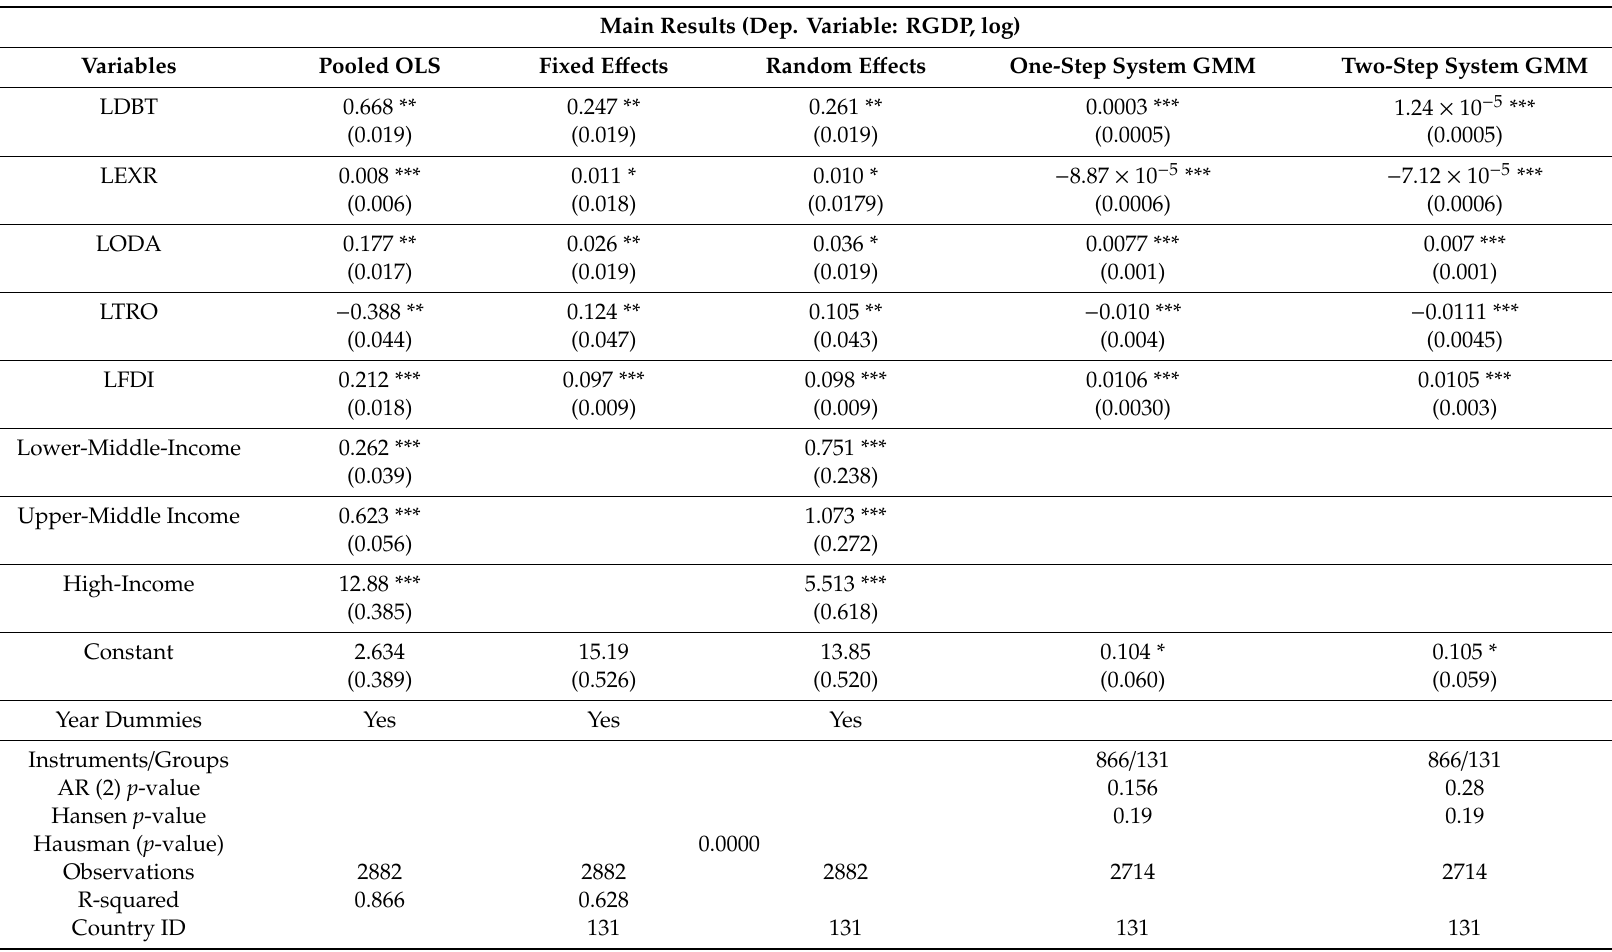
Table 7. Results for main model estimation across several techniques compared with system